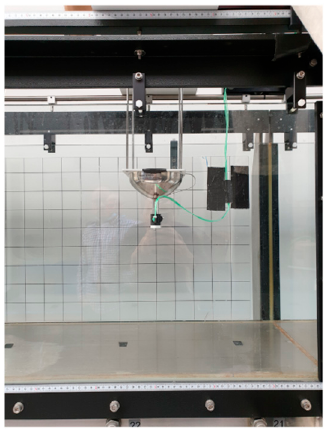
Figure 4. Detailed view of the particle inlet funnel.